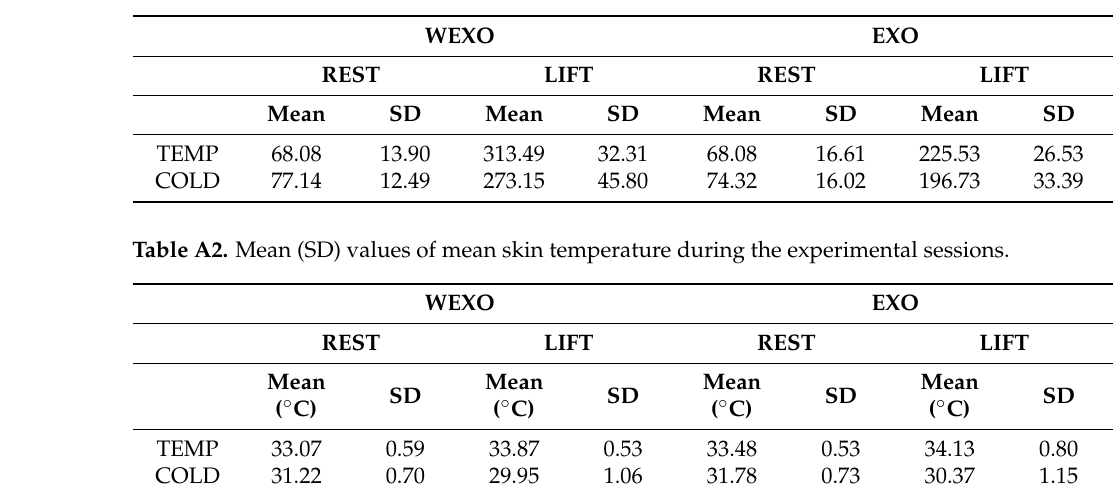
Table A1. Mean (SD) values of metabolic rate (W/m 2 ) during the experimental sessions.